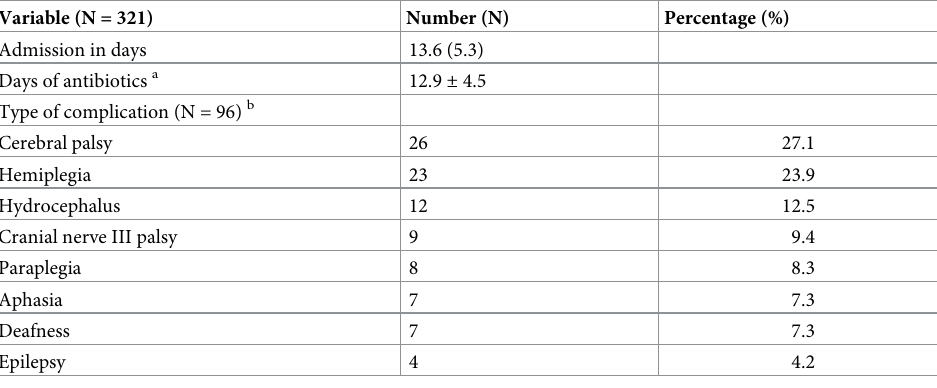
Table 4. Treatment and outcomes of 321 ABM children.